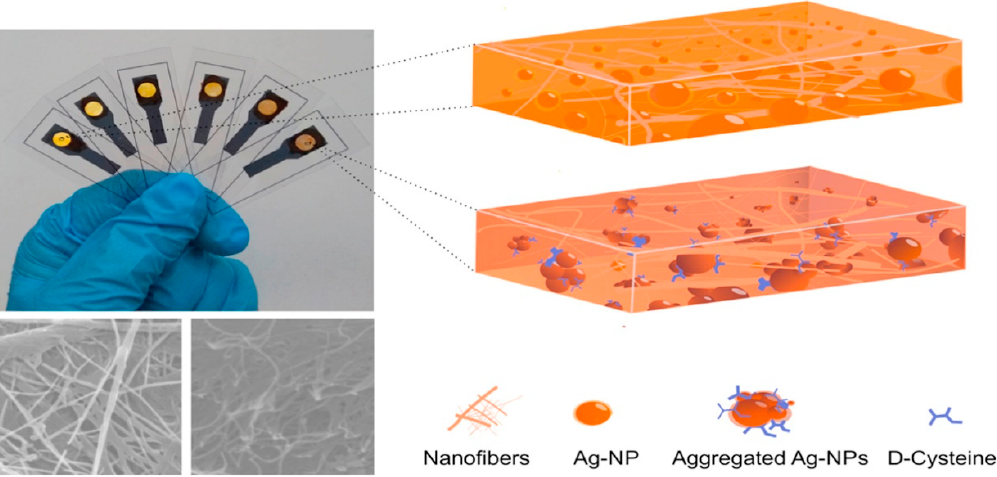
Figure 9. Schematic representation of the chiral nanopaper for the colorimetric determination of D-cysteine. Reprinted with permission from [89], Copyright Elsevier,